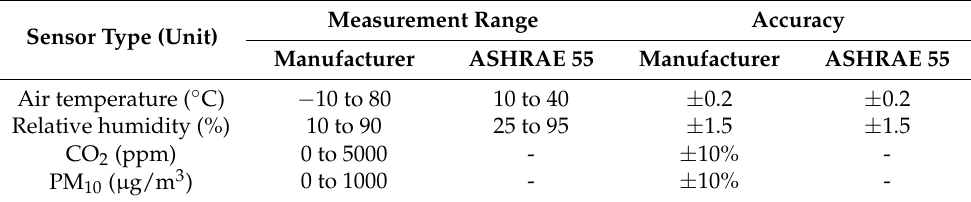
Table 1. Measurement range and accuracy of the multiple monitoring